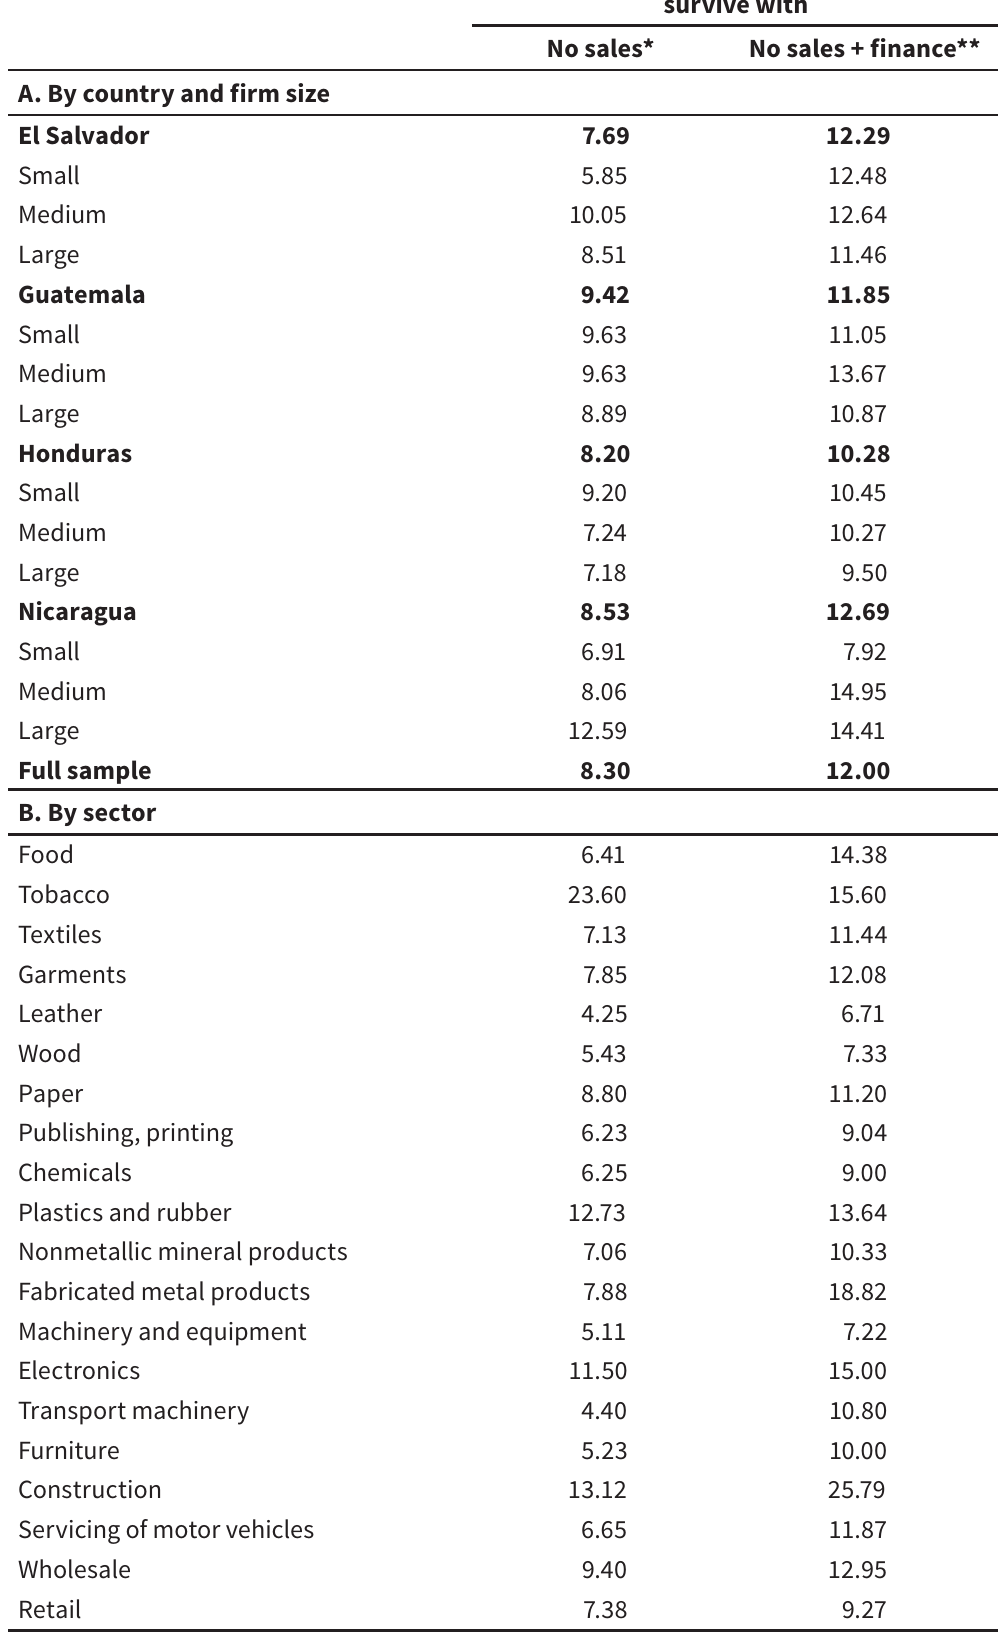
Expected survival times of